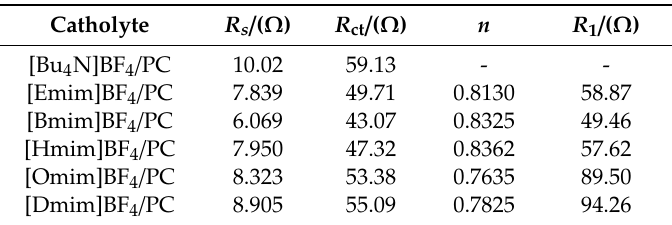
Table 2. Parameter values of equivalent circuit